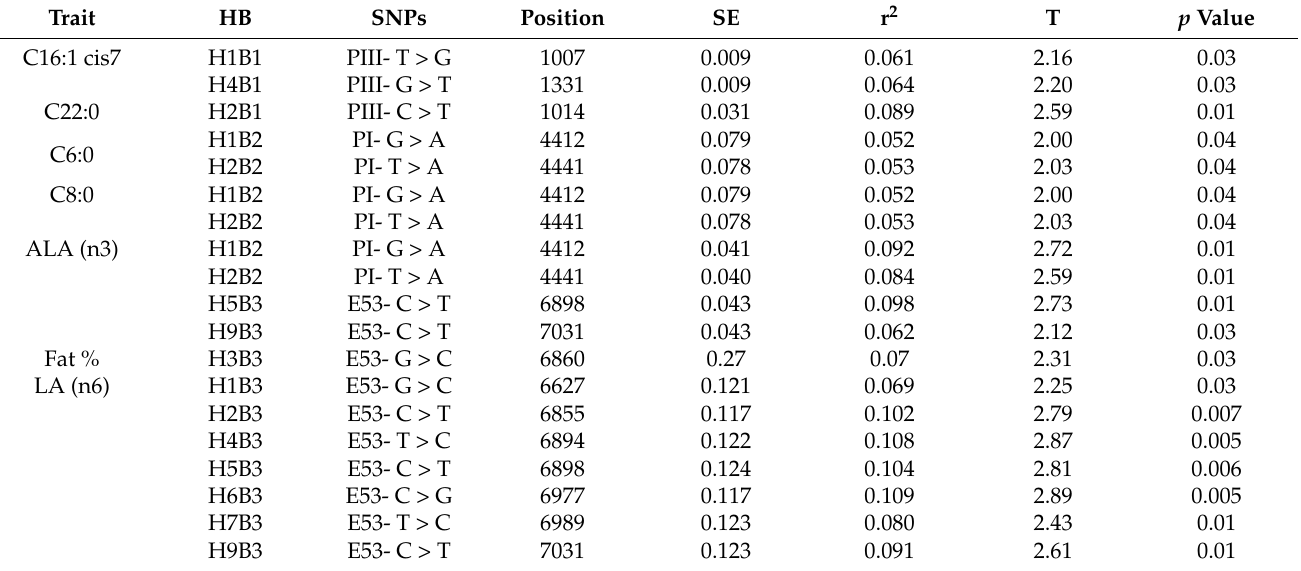
Figure 3. Three blocks of 21 haplotypes (HB) with different forms were identified in the ACAC α gene of Najdi sheep: HB1 (6 haplotypes), HB2 (7 haplotypes), and HB3 (10 haplotypes). Table 7. Associations of haplotypes in different blocks with milk fat (%) and fatty acid profiles (g/100 g) in Najdi